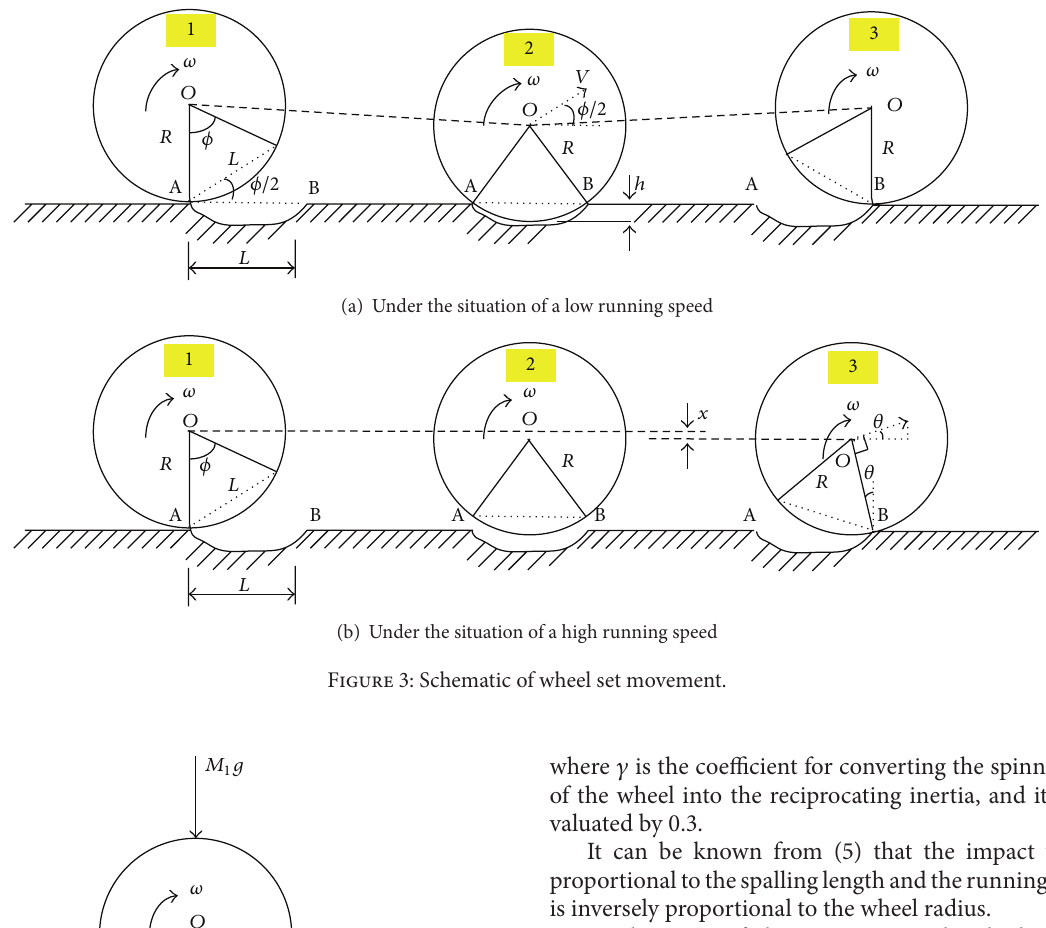
Figure 3: Schematic of wheel set movement.